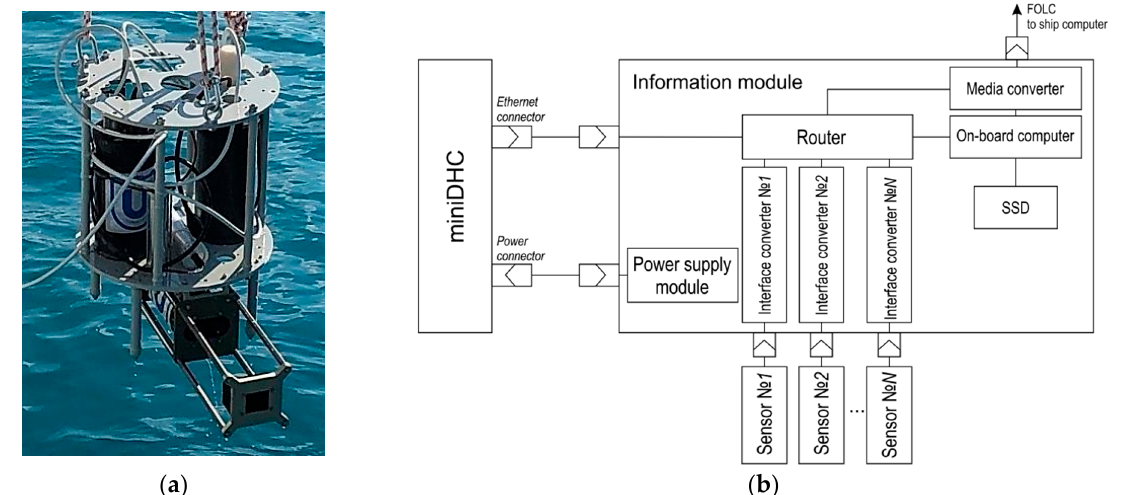
Figure 2. ( a ) MiniDHC as part of the hydrobiological probe. ( b ) Block diagram of the miniDHC connection, additional sensors and information module.